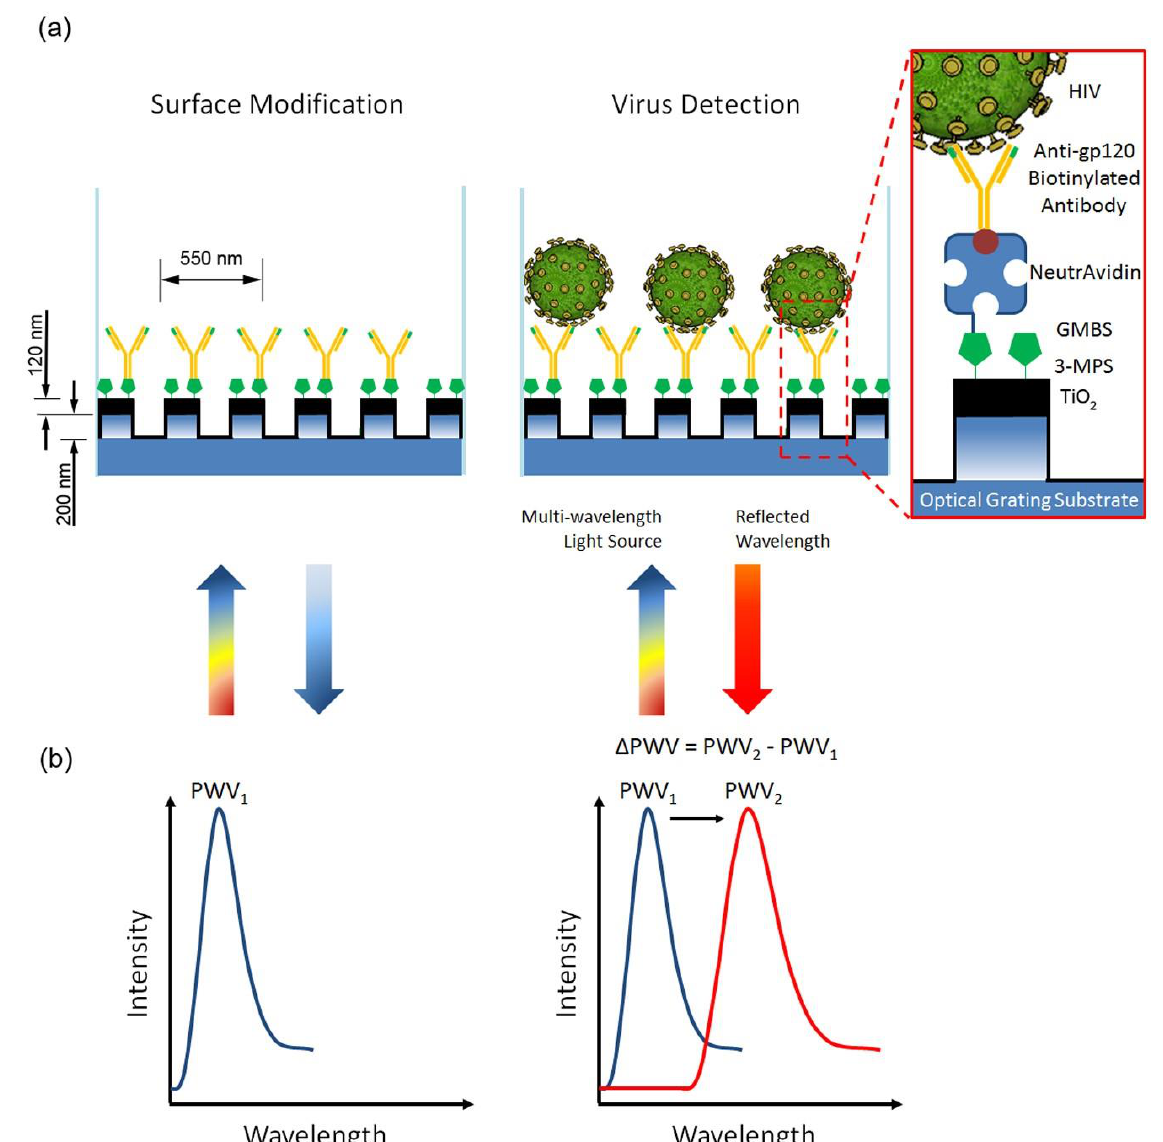
Figure 6. Design and construction of photonic crystal (PC)-based intact virus detection platform. ( a ) The bottom surface of PC biosensor microplate wells comprises a nanostructured subwavelength grating coated with TiO 2 . ( b ) Binding events within the close vicinity of the sensing area change the bulk index of refraction; thus, the reflected light’s peak wavelength value (PWV) is altered. The shift in the peak wavelength ( ∆ PWV) is directly proportional to the binding of molecules and bioagents (e.g., cells and viruses) onto the biosensing surface (adapted with permission from Shafiee et al., Nature Reports 2014 [65]).